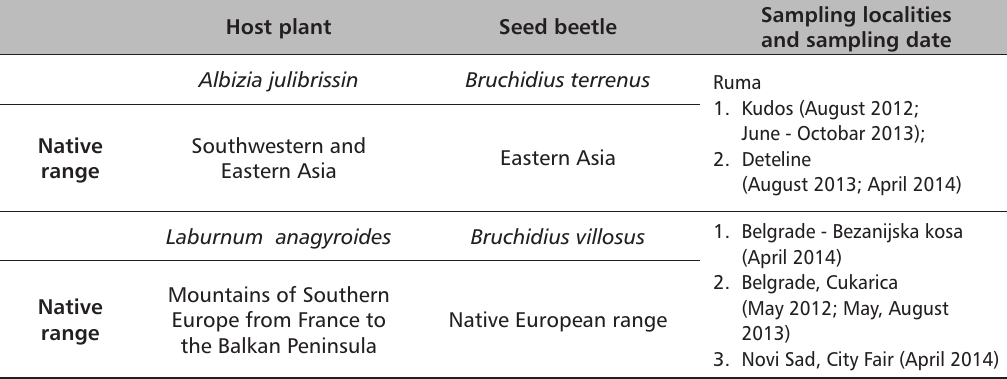
TABLE 1. Host plant and seed beetles native range, sampling localities and sampling date in Serbia Host